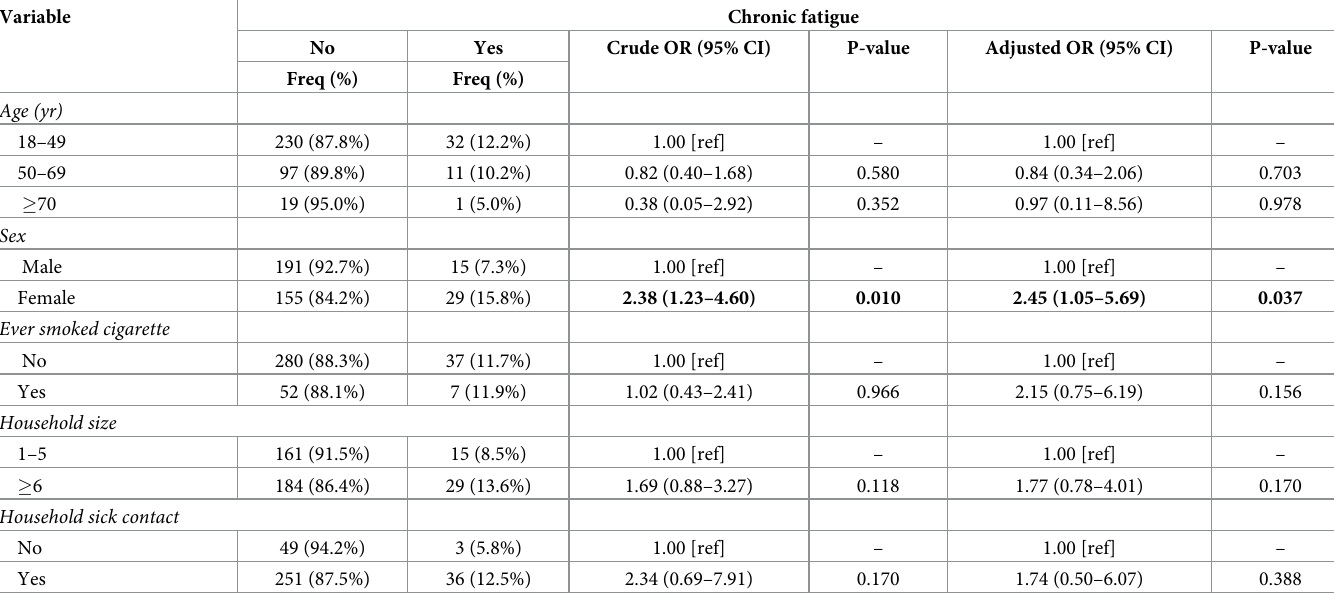
Table 3. Associations of chronic fatigue after